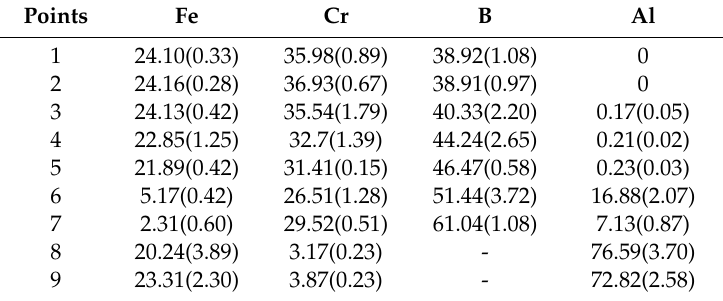
Figure 8. ( a ) STEM-HAADF mappings of the interface. ( b ) The measured concentration profiles along the red line. Table 4. Mean values of measured concentration profiles at locations marked in Figure 8 by TEM-EDS (in at.%, standard deviation given in parentheses).